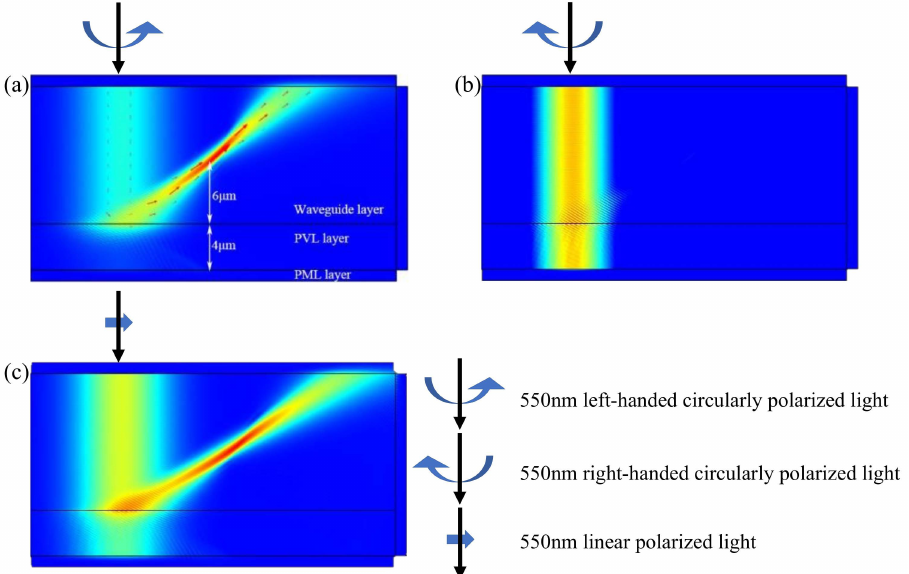
Figure 2. Electric field simulation diagram of PVL simulation structure with a central wavelength of 550 nm in a vacuum responding to left-handed circular polarization. The incident light is ( a ) 550 nm left-handed circularly polarized light, ( b ) 550 nm right-handed circularly polarized light, and ( c ) 550 nm linearly polarized